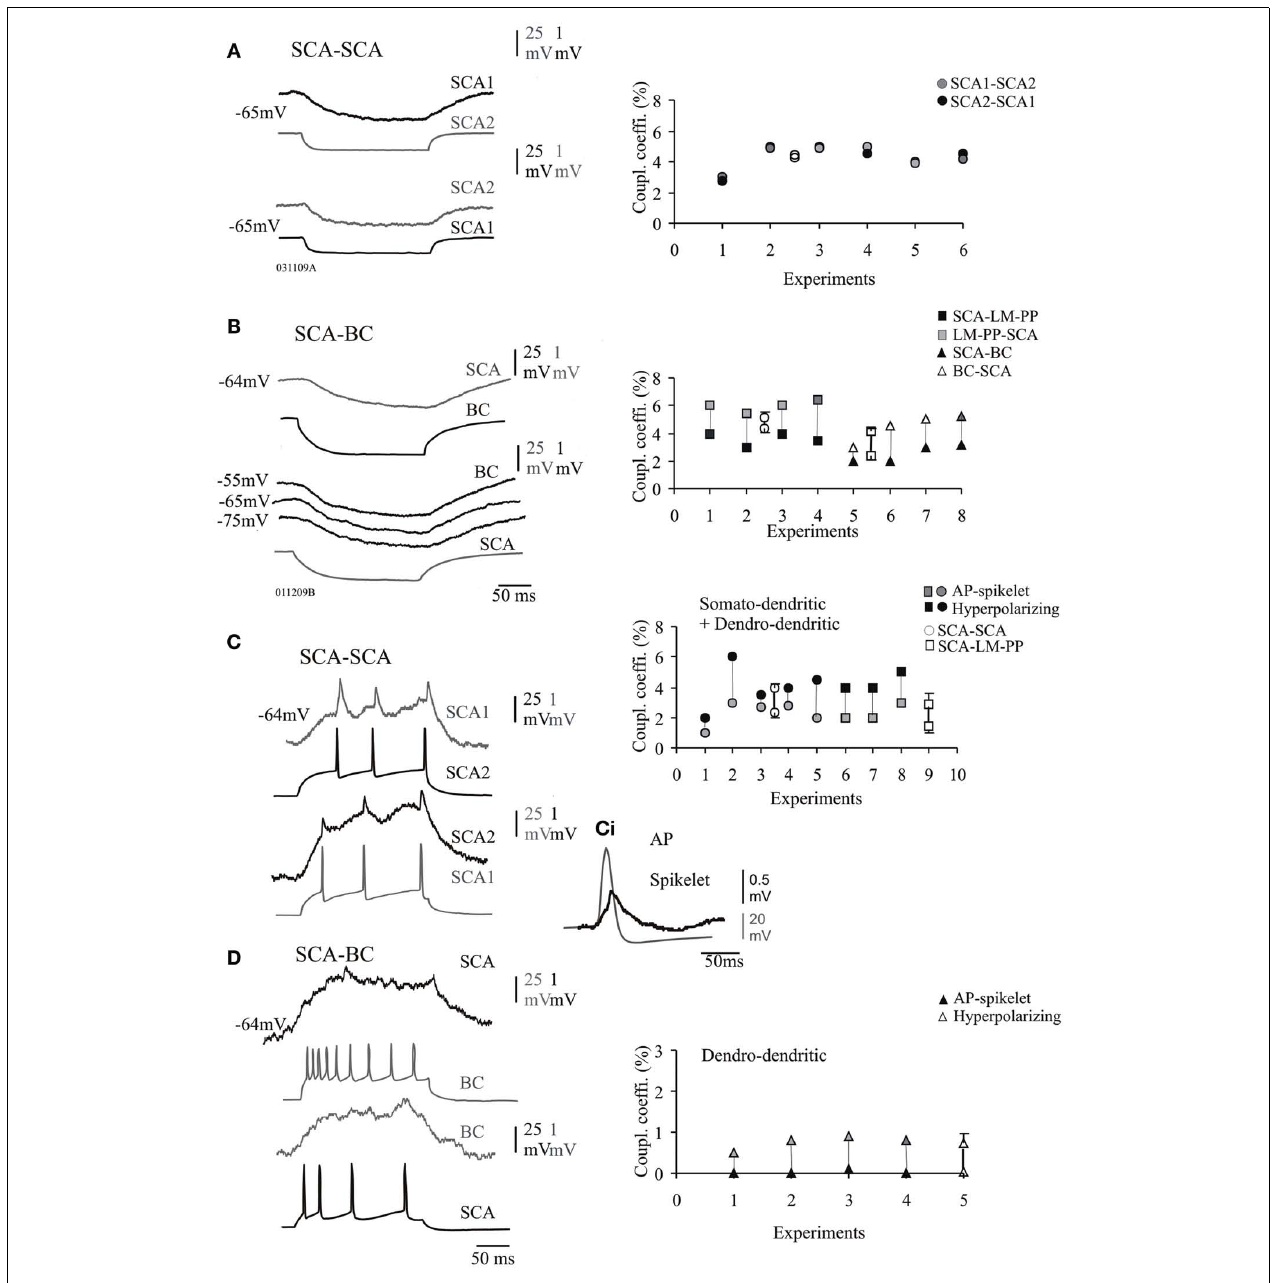
spikelet are superimposed and shown on a larger scale.The adjacent plots illustrate the spike coupling coefficients from individual pairs of SCA–SCA and SCA–LM–PP cell connections which were seen to have close somato-dendritically and dendro-dendritic contacts at the